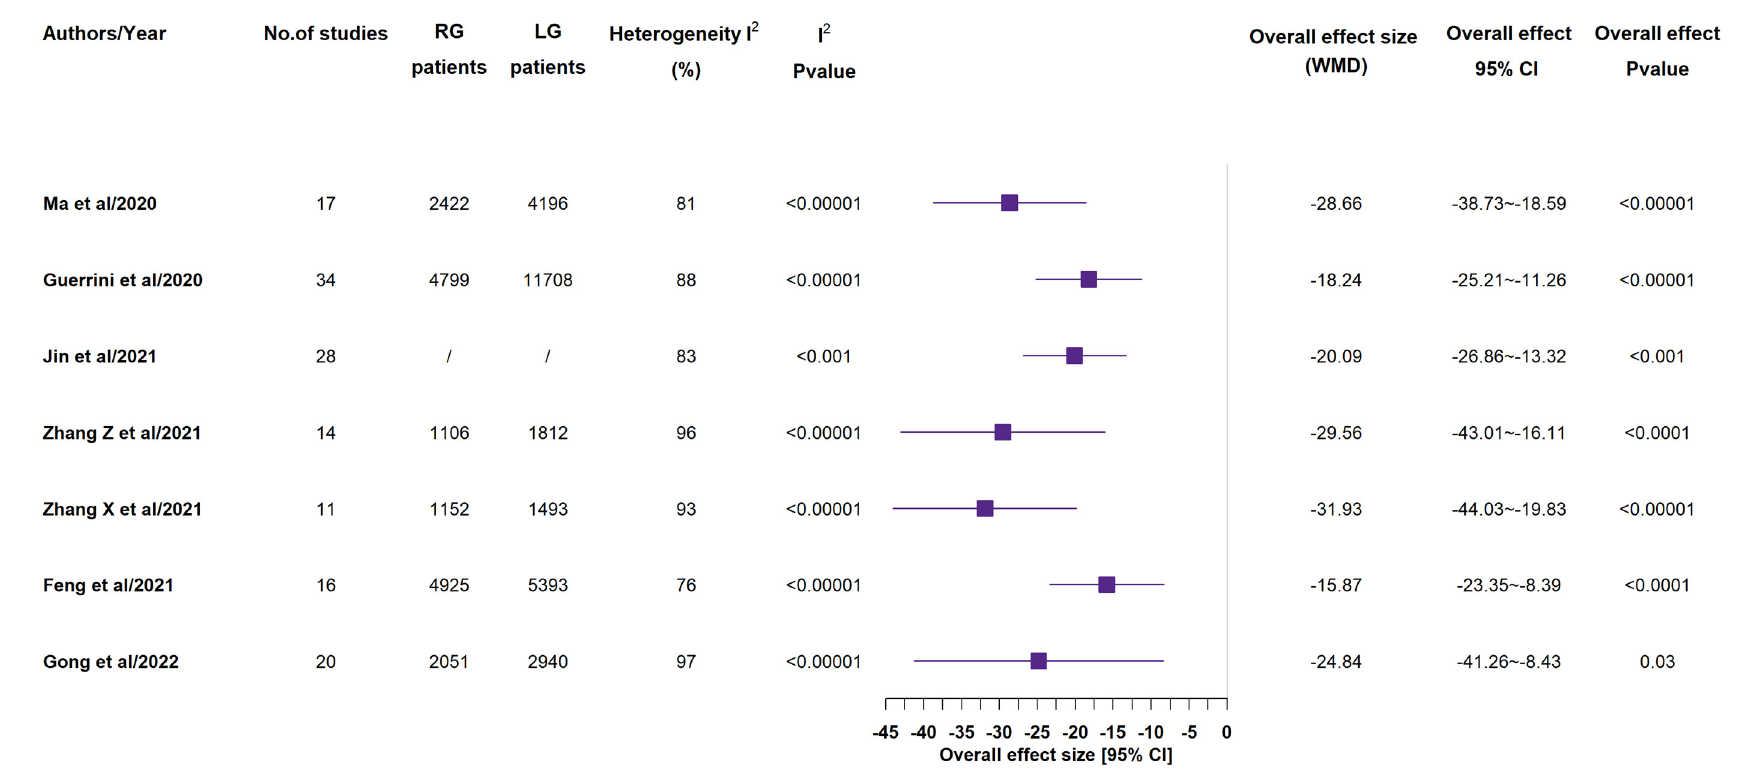
Figure 3. Estimated blood loss (mL). RG = Robotic gastrectomy; LG = Laparoscopic gastrectomy; WMD = weighted mean difference